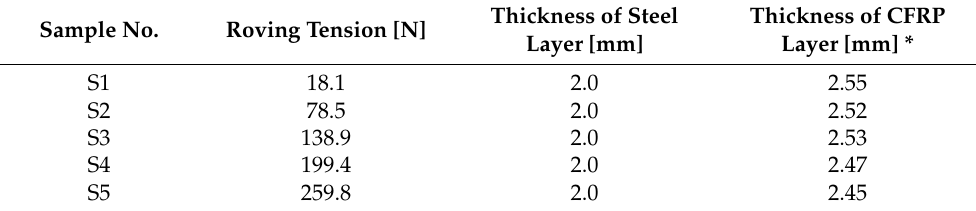
Table 1. Parameters of carbon fibre-reinforced polymer (CFRP).